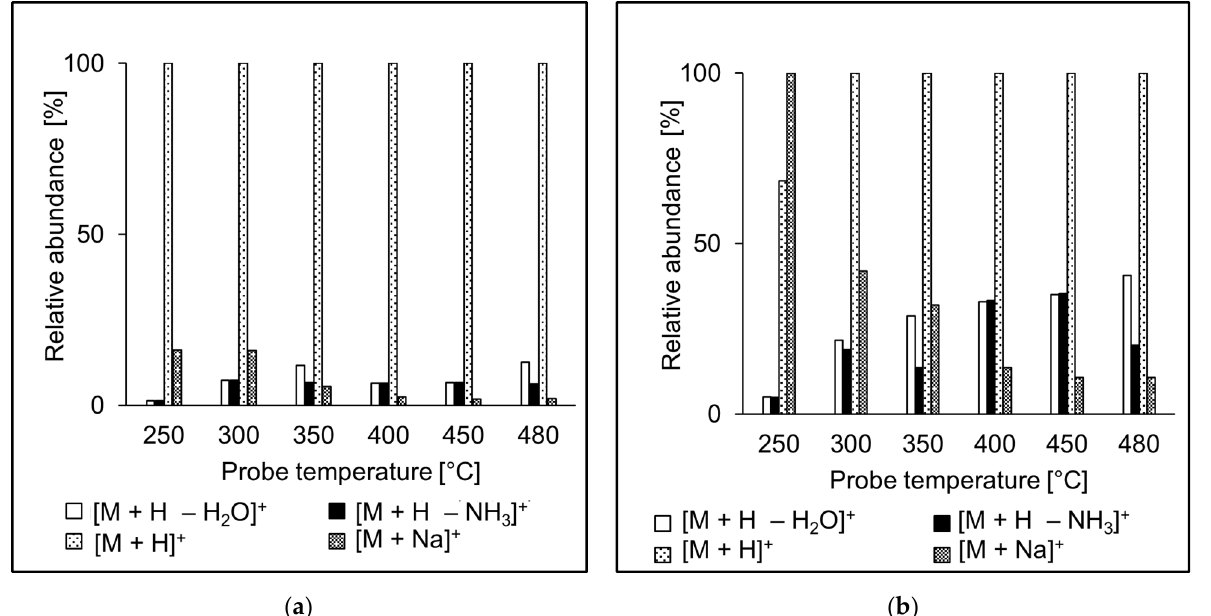
Figure 4. Effect of the probe temperature on the relative abundances of major ions in ( a ) APCI and ( b ) APPI full scan mass spectra of AEFVEVTF. Data obtained by flow injection analysis (FIA) using methanol/water (80:20 v/v) mobile phase.